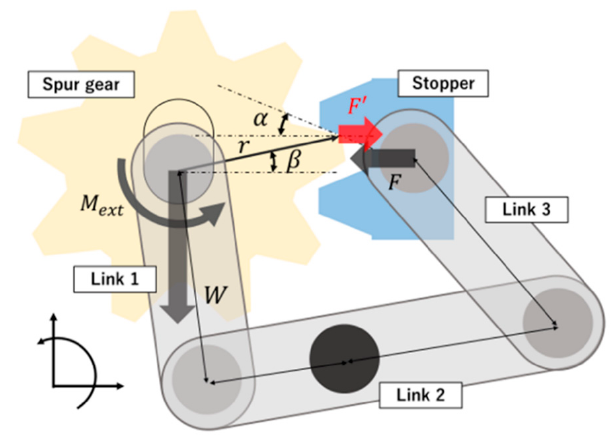
Figure 3. Forces and moments acting on the gear and stopper.